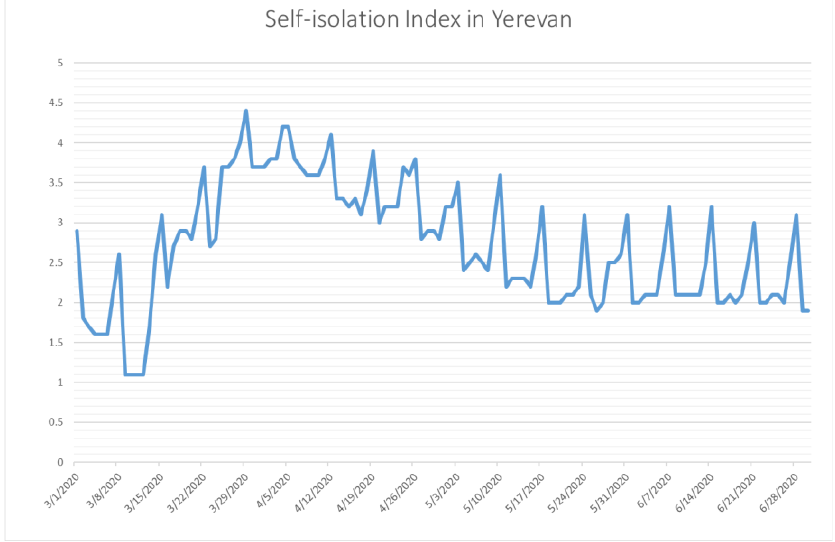
Figure 5 . Yandex self-isolation index in Yerevan during the March-June 2020 period Figure 5. Yandex self-isolation index in Yerevan during the March-June 2020